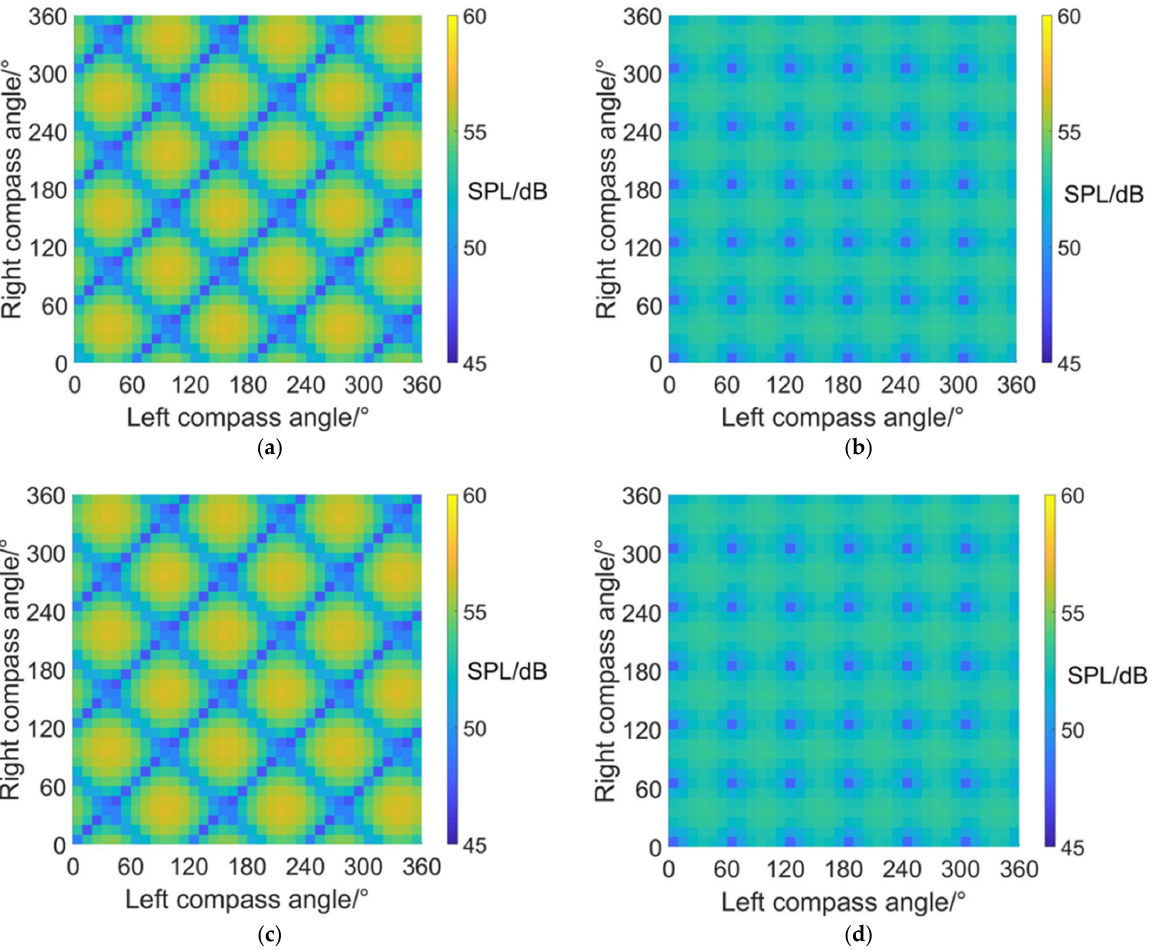
Figure 12. Carpet diagrams of noise SPL in helicopter mode at an azimuth angle = 180 ◦ with a scissors angle difference = ( a ) 0 ◦ , ( b ) 30 ◦ , ( c ) 60 ◦ , ( d ) 90 ◦ Table 7. Maximum and minimum SPL values at an azimuth angle = 180° in helicopter mode.